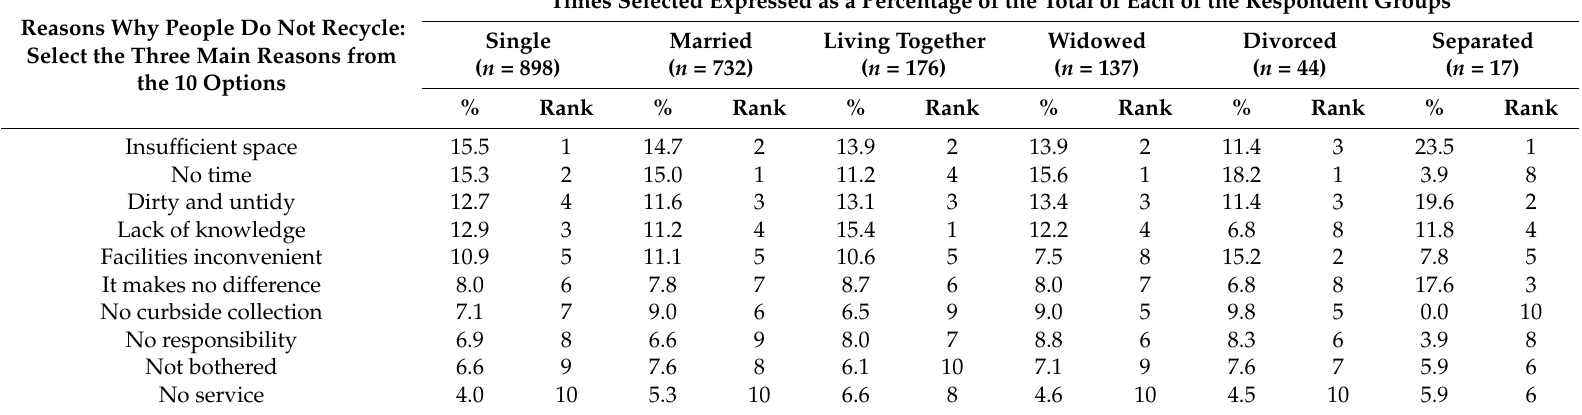
Table A7. Reasons why people do not recycle as enumerated per marital status ( n = 2004).